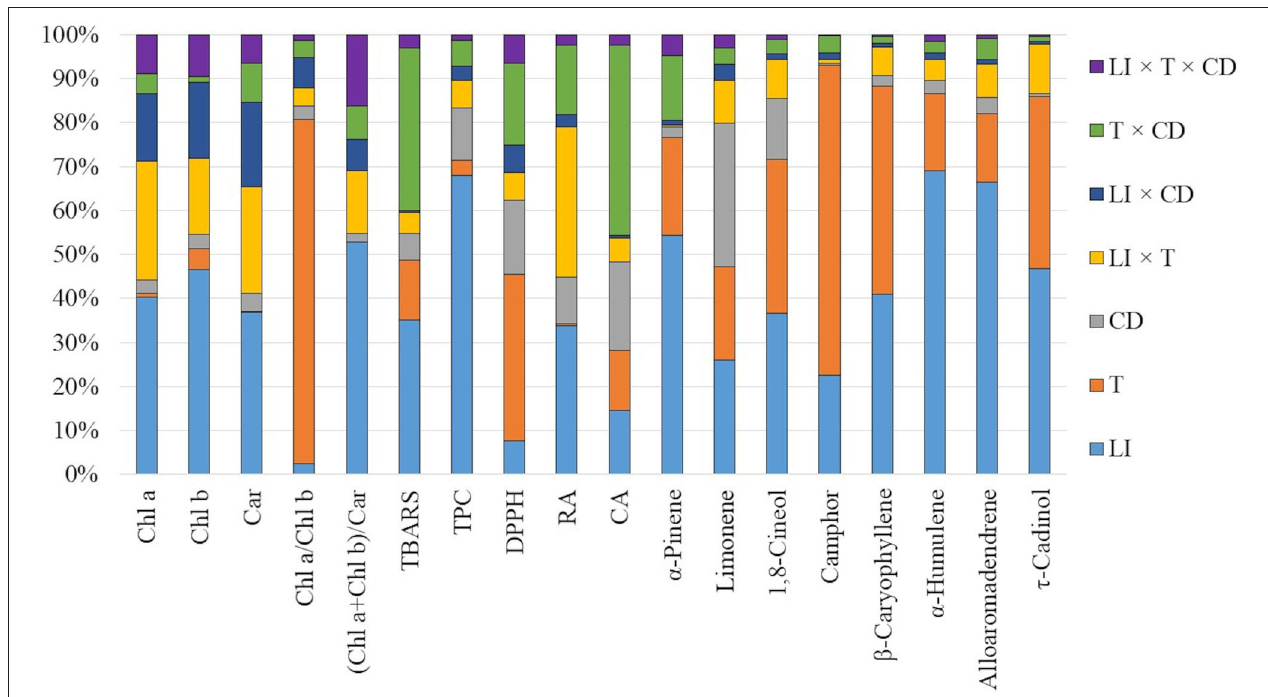
FIGURE 3 | The relative contribution of light intensity (LI), temperature (T), and culture duration (CD) and their interactions to variation in the metabolic response of S. yangii in vitro